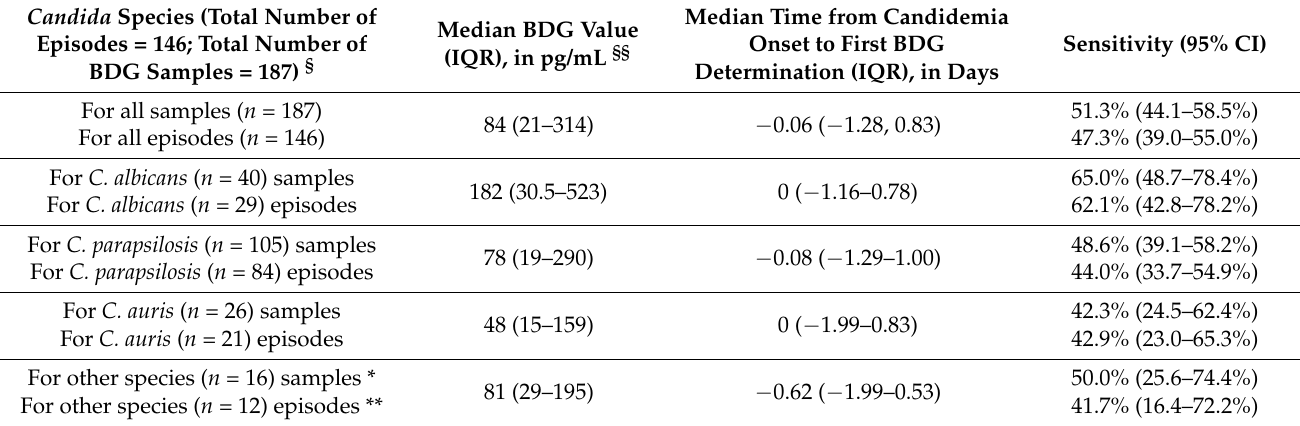
Table 1. Serum BDG values, overall sensitivity, and sensitivity stratified according to Candida species.